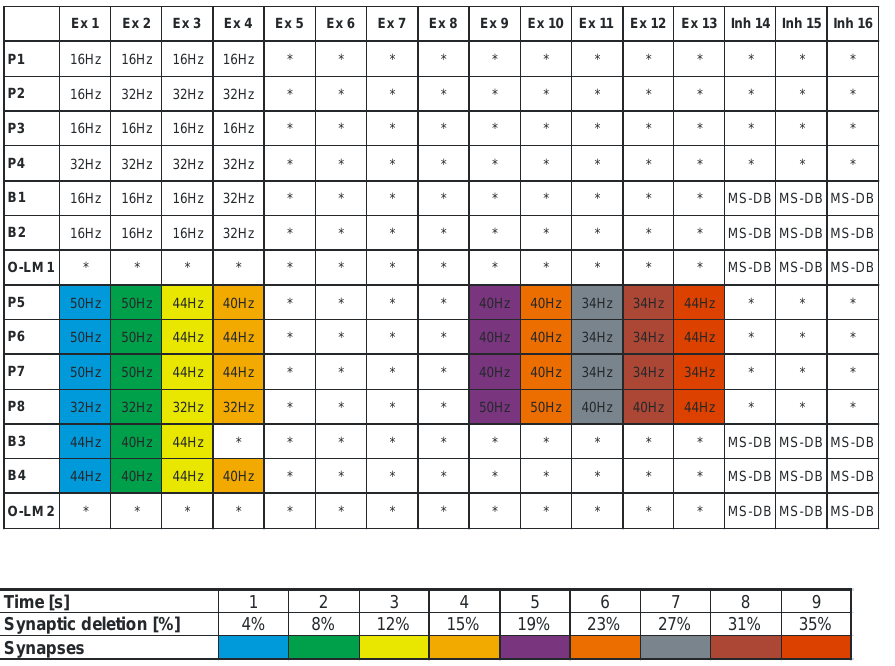
bottom). ( b ) Example – pyramidal cell. Red excitatory, green inhibitory inputs. Pyramidal cell model configuration with color filled postsynaptic regions according to values of LTP at the end of simulation.